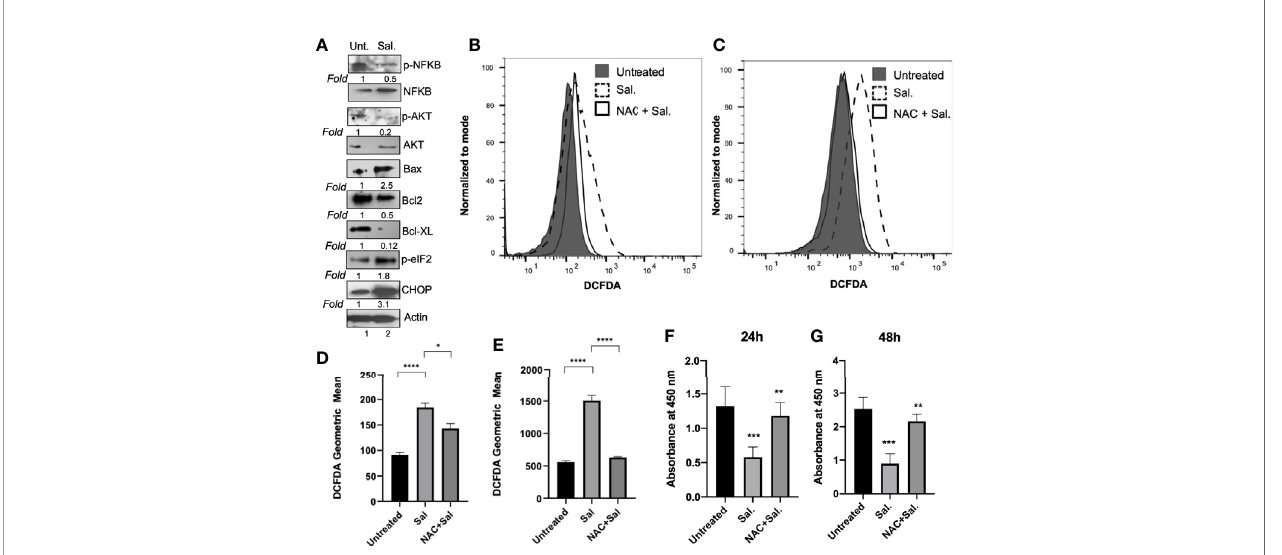
FIGURE 7 | Salubrinal treatment induces cell death potentially by induction of ROS in IBC cells. (A) SUM149PT cells were cultured with or without 10 m M Salubrinal for 48 hours. Lysates prepared and tested for various in fl ammation, proliferation, and apoptosis-speci fi c proteins as indicated by Western blot analysis. Blots were reprobed with anti- b -actin antibody as a loading control. p-NF k B and p-AKT were normalized with respect to total NF k B and AKT, respectively. The level of proteins in untreated samples was considered one for fold activation or down-regulation using the quantitation method as described in the Methods section. (B) ROS analysis in SUM149PT cells (untreated, Salubrinal treated or NAC and Salubrinal treated) for 48h was done. Raw data of DCFDA fl uorescence peaks of a representative experiment. (C) ROS analysis in SUM149PT cells (untreated, Salubrinal treated or NAC and Salubrinal treated) for 48h was done. Cells were pulsed with H 2 O 2 right before analyses in the fl owcytometer. Raw data of DCFDA fl uorescence peaks of a representative experiment. (D, E) Quanti fi cation of ROS levels from (B, E) , respectively. Each reaction was done in triplicate, and each bar represents the geometric mean ± SD for three experiments. (*), p<0.05 and (****) p<0.001 indicate a statistically signi fi cant difference between either untreated and Salubrinal treated or Salubrinal treated and NAC and Salubrinal cotreatment. (F, G) Cell proliferation assay in SUM149PT cells (untreated, Salubrinal treated or NAC and Salubrinal treated) for 48h was measured by BrdU assay as described in the methods section. Each reaction was done in triplicate, and each bar represents the absorbance mean ± SD for three experiments. (**), p<0.01 and (***) p<0.005 indicate a statistically signi fi cant difference between either untreated and Salubrinal treated or Salubrinal treated and NAC and Salubrinal